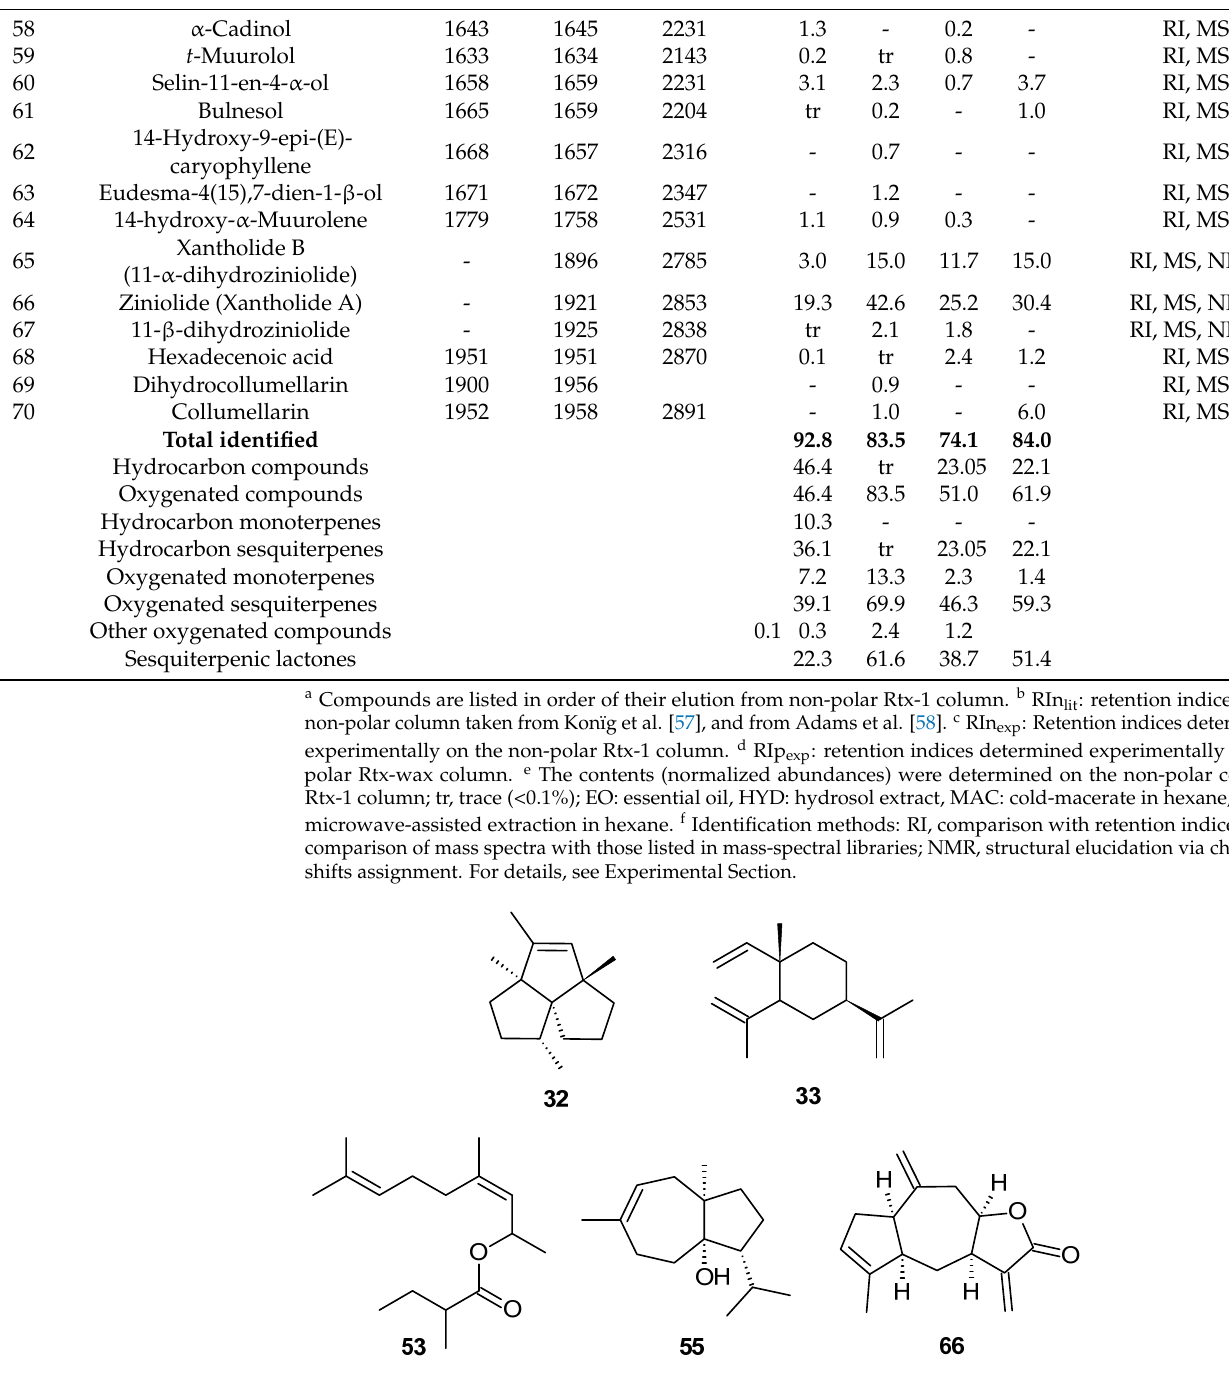
Figure 1. Structures of main components of X. spinosum root essential oil from Corsica; α -isocomene 32 , β -elemene 33 , neryl 2-methylbutyrate 53 , carotol 55 , ziniolide 66 Hydrosol was treated by liquid–liquid extraction and the integrated analysis of hy- drosol extract (HYD) identified 40 components that accounted for 83.5% of the total amount (Table 1). Chromatogram of the HYD is available in supplementary material (Fig- ure S4). Relative to EO, hydrosol extract was exclusively composed of oxygenated com- pounds; monoterpenoids amounted to 13.3% and the number of sesquiterpene lactones